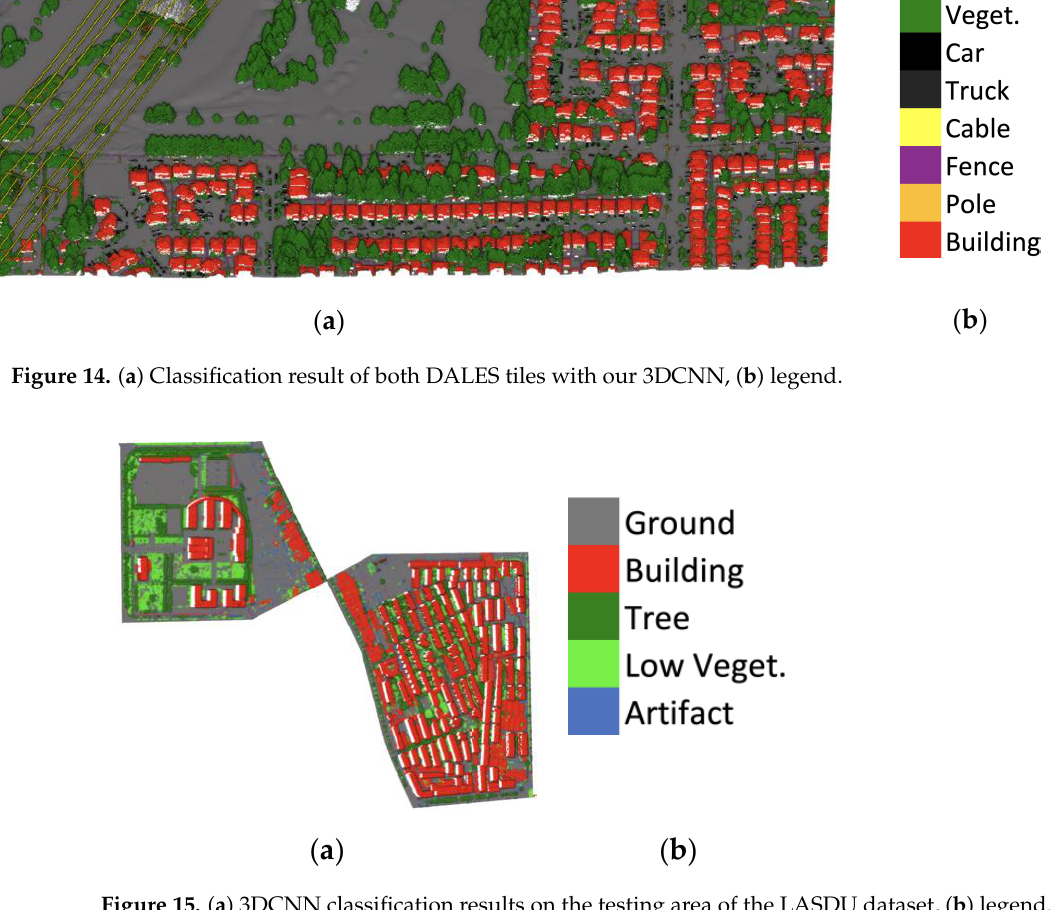
( b ) Figure 16. ( a ) Classification result on the testing area of the Bordeaux dataset with our 2DCNN, ( b ) legend. Table 11. Average and weighted F1 and IoU scores for 2DCNN and 3DCNN classifiers for the 3DOMCity dataset. The OA is also reported. Ground Grass Shrub